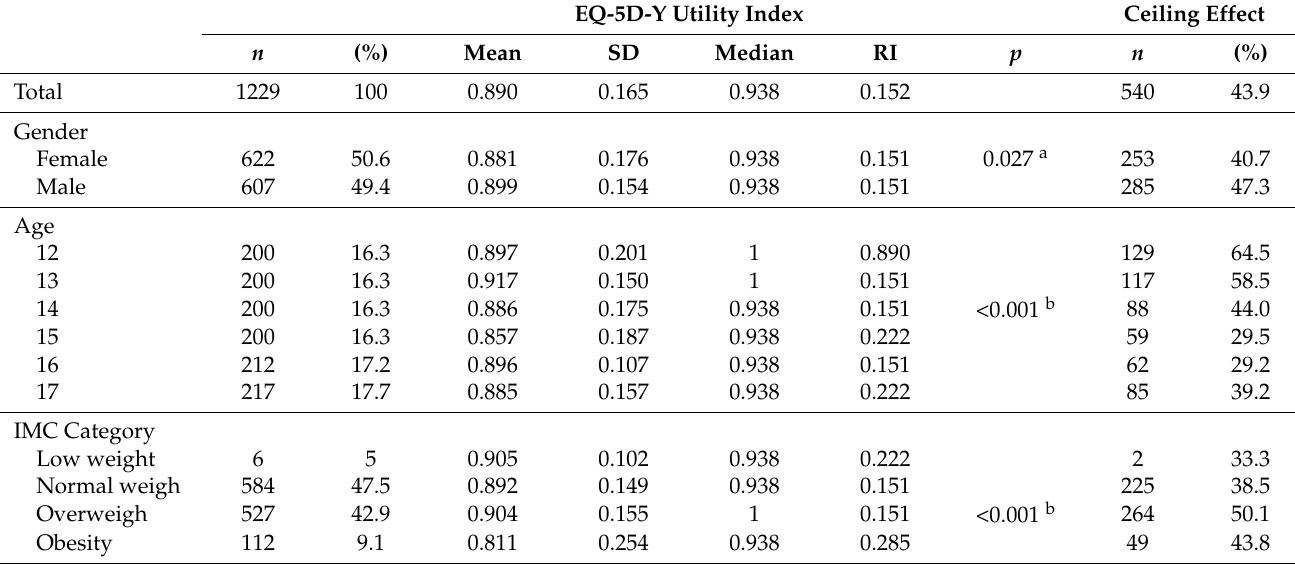
Table 1. Sample characteristics. EQ-5D-Y adolescents’ population normative